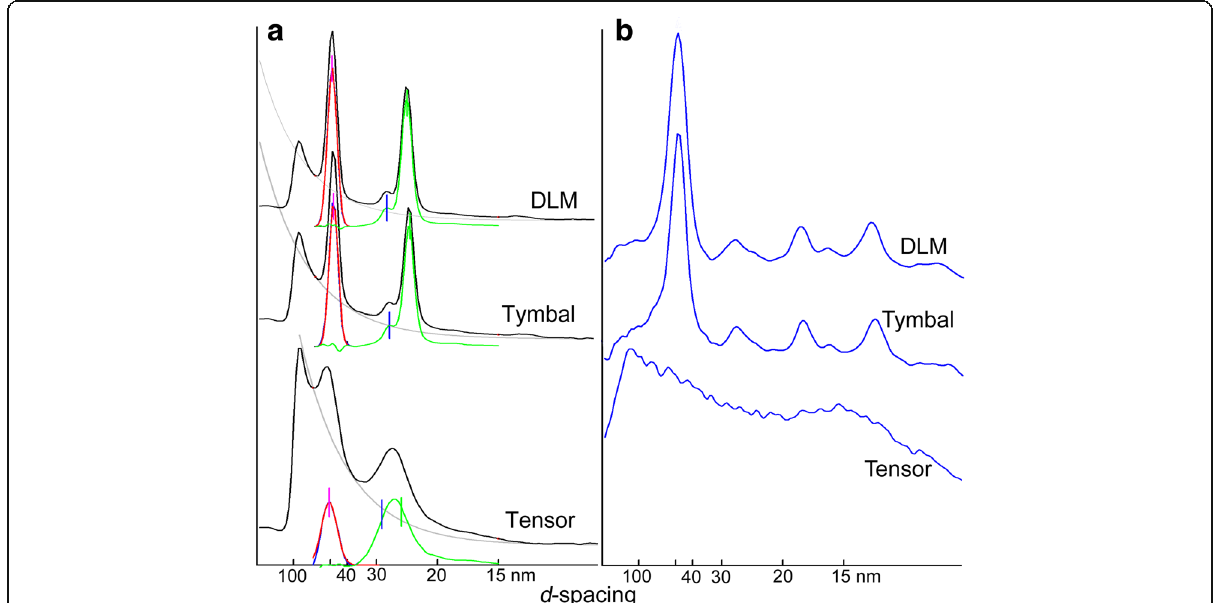
Fig. 4 Intensity profiles of the equatorial ( a ) and the first myosin/actin layer line ( b ) reflections, taken from the diffraction patterns from Meimuna oparifera in Fig. 3. In a , the red curve is the Gaussian fit of the 1,0 reflection after subtraction of the background, approximated as a single exponential decay function (gray). The blue curves (almost hidden underneath the red curves) are the observed intensity profile after subtraction of the background. The green curve is the residual remaining after the Gaussian fit of the 1,0 is further subtracted. The red vertical bar is the center of the Gaussian fit of the 1,0, and the blue and green vertical bars are the positions of the 1,1 and 2,0 reflections, respectively, calculated from the position of the 1,0 reflection. The leftmost peak is the edge of the beamstop. Note that the 2,0 reflection is much more intense than the 1,1 in flight and tymbal muscles except for the